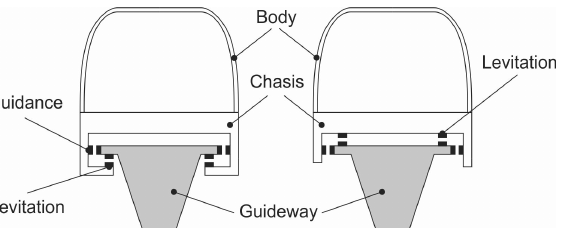
Figure 1. Two possible levitation setups (attraction-( left ), repulsion-( right )) [9,14]. In the case of repulsion, the open loop system is stable. If, however, attraction is being used, the system is open loop unstable and is useless without a proper closed-loop design. In order to study magnetic levitation control, various experimental setups have been used [15,16] but the most commonly used experimental setup is the one shown in Figure 2